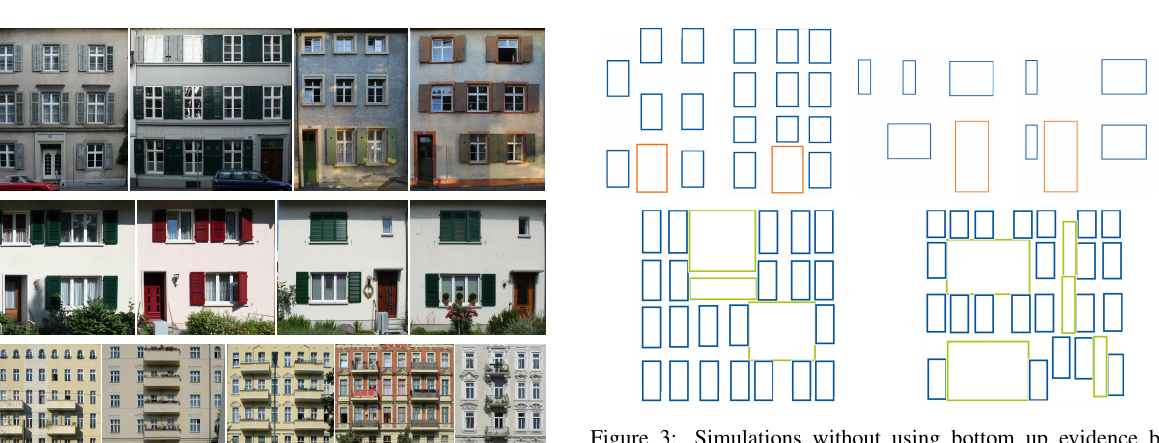
Figure 3: Simulations without using bottom up evidence by an image, just based on learned configuration statistics from datasets: Top: two images each: Basel old town, Basel row houses. Bottom city houses with balconies. Colours: Blue: win- dows. Orange: entrances. Green: